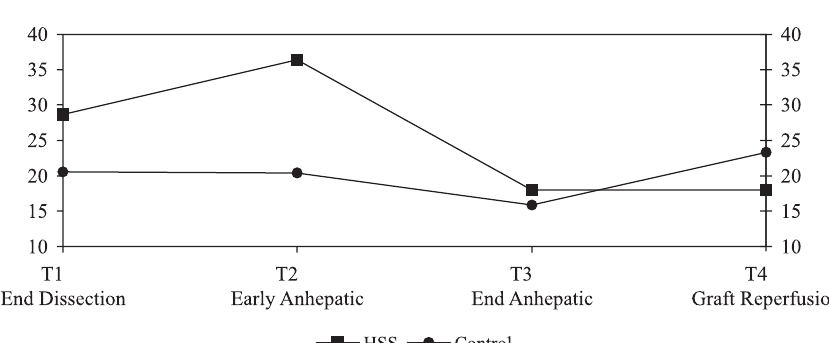
Figure 1 – Intracranial